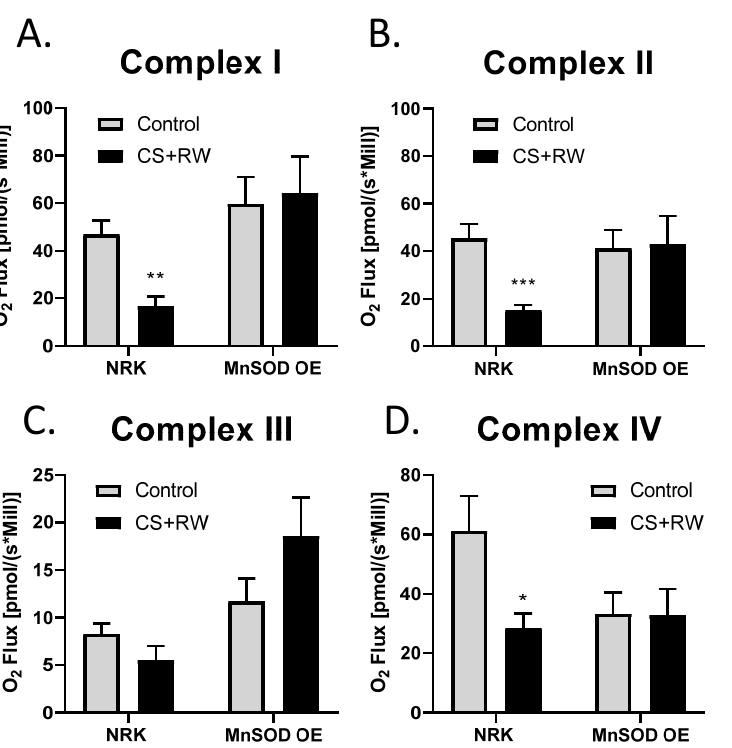
Figure 5. MnSOD overexpression mitigates CS + RW-induced mitochondrial respiratory dysfunction in NRK cells. High- resolution respirometry was used to measure mitochondrial respiration at electron chain complexes I–IV ( A – D ) in NRK cells and NRK cells overexpressing MnSOD. There was a statistically significant decrease in mitochondrial respiration in complex I, complex II and complex IV in CS + RW compare to control in NRK cells; however, this was prevented in NRK cells overexpressing MnSOD. Unpaired t-test was used to assess differences between conditions. Values are expressed as ±SEM ( n = 7 – 11). * p < 0.05, ** p < 0.01 and *** p < 0.001.